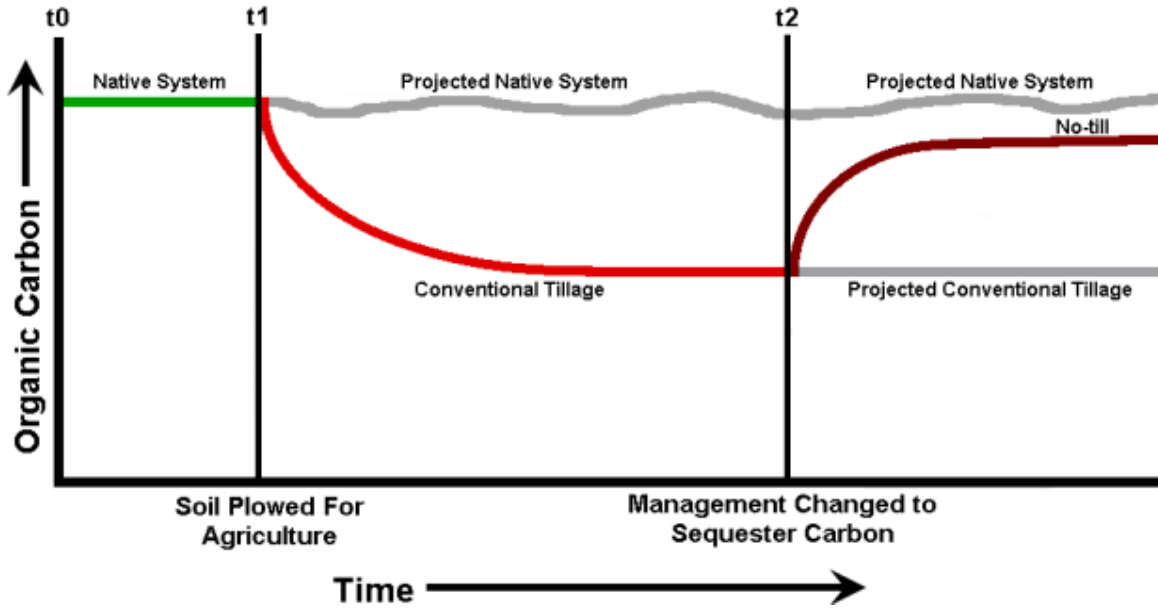
Figure 3. Tilling a native soil leads to reduced soil organic C levels, while management changes such as a conversion to no-till techniques may lead to increased soil organic C as compared to conventional tillage techniques